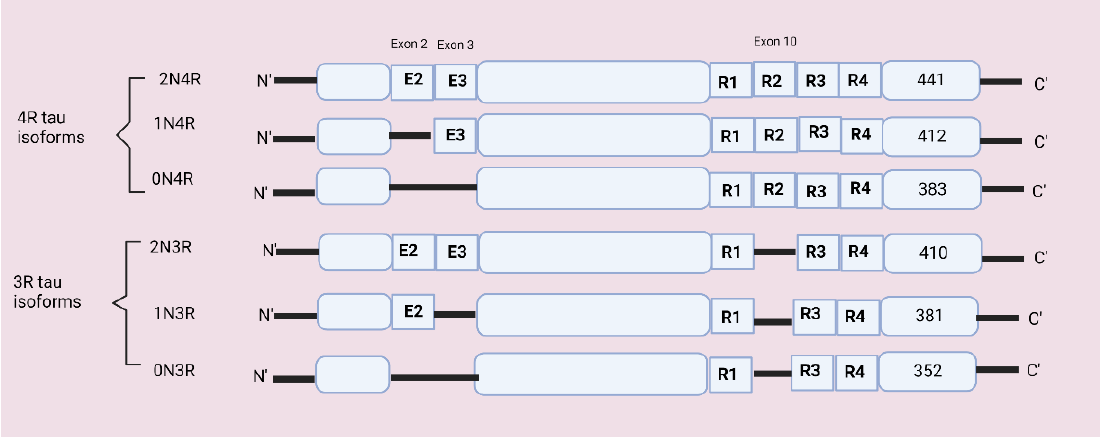
Figure 2. MAPT gene and 6-isoforms structure: The tau gene is located on chromosome 17q21 and contains 16 exons. Six isoforms of tau are generated by alternate splicing of the exons 2, 3, and 10 of the MAPT gene. The N terminal domain, N1 and N2, are produced from exons 2 and 3. These isoforms differ in length from 352 – 441 amino acids.